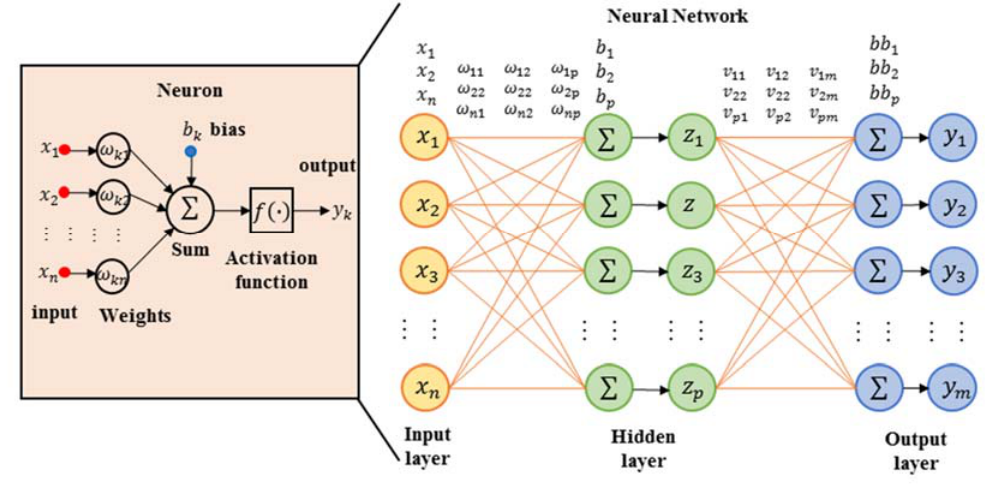
Figure 1. Structure of neural network.